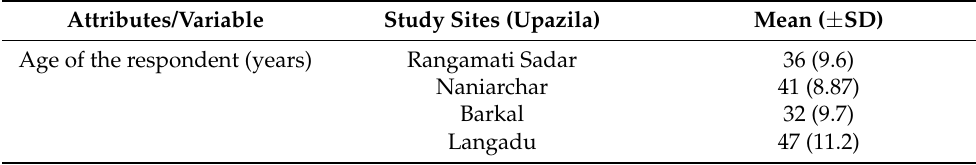
Table 4. The average ages of the respondent fishers in four study areas in Kaptai